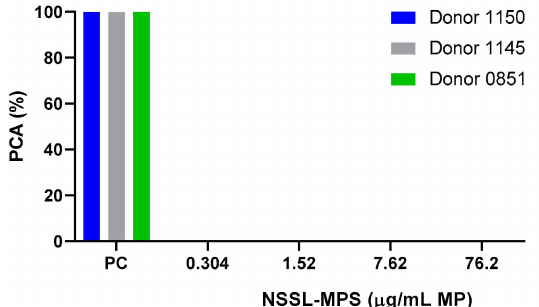
Figure 4. Leucocyte pro-coagulant activity in the presence of NSSL-MPS. Di ff erent concentrations of NSSL-MPS were tested for their ability to induce leukocyte pro-coagulant activity. Briefly, peripheral blood mononuclear cells (PBMC) isolated from healthy blood donor volunteers and HL-60 cells were incubated (24 h for PBMC and 5 h for HL-60 cells) with NSSL-MPS at 0.304, 1.52, 7.62 or 76.2 µ g / mL MPS. Isolated cells from the di ff erent conditions were then used to initiate plasma coagulation. PC, Positive Control; PCA, Pro-Coagulant